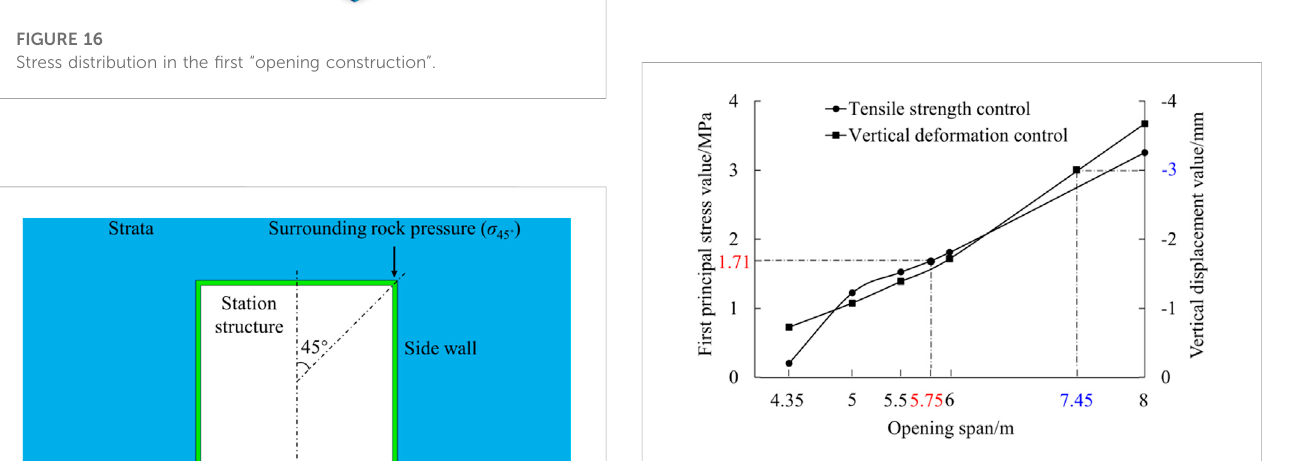
FIGURE 19 Stress distribution around the side wall opening.